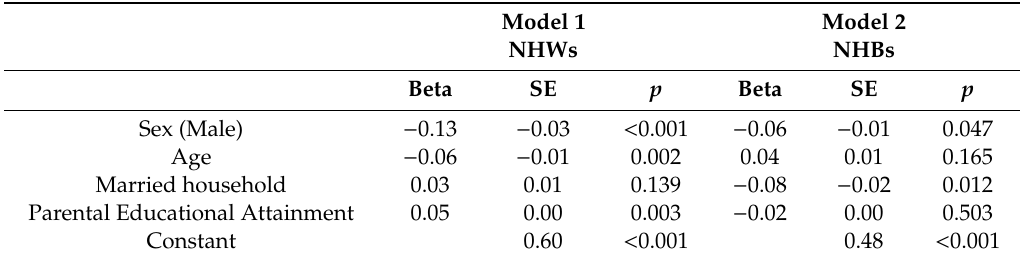
Table 3. Summary of linear regressions by race / ethnicity ( n = 4183).